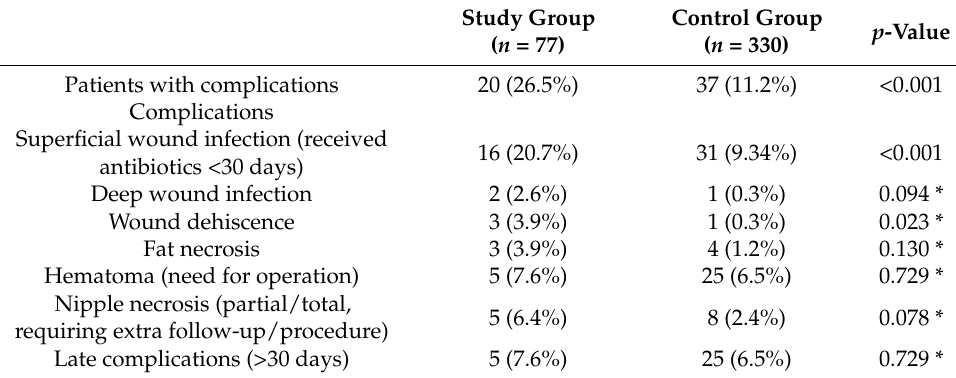
Table 3. Postoperative complications at follow-up. Study group included patients who experience a prolonged sick leave versus the other ones.